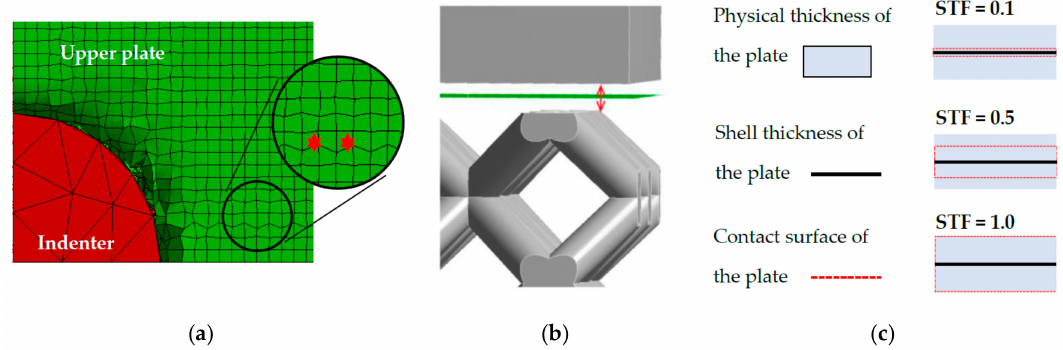
Figure 8. ( a ) Hour-glassing energy error; Shell thickness factor—( b ) Shell mid-surface of the upper plate; and ( c ) Description of the contact